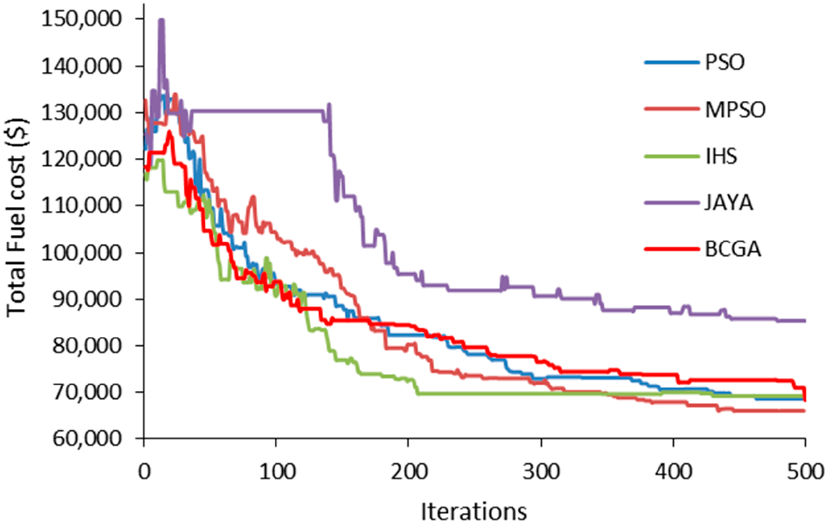
Figure 9. Convergence characteristics of MPSO, PSO, BCGA, IHS, and JAYA algorithms in terms of total fuel cost.